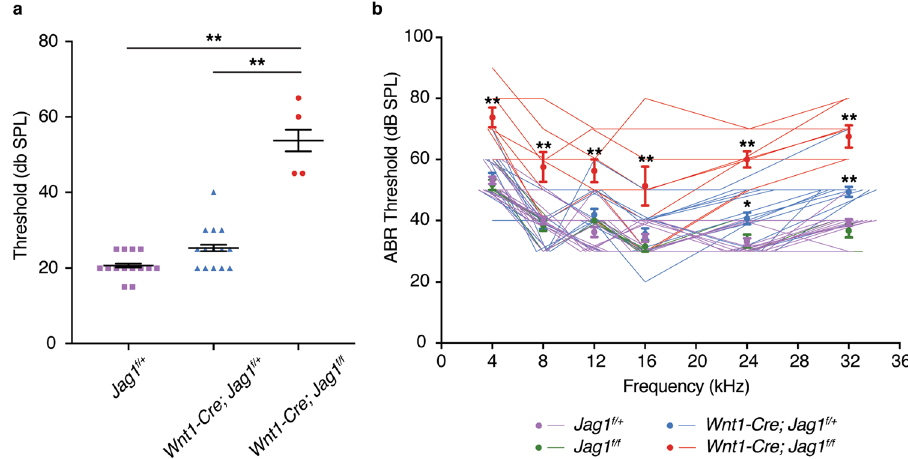
Figure 4. Hearing loss in mice lacking Jag1 in NCCs. ( a ) A click stimulus test was performed in P18 mice, a stage at which wild-type mice show normal hearing. Compared to Jag1 f/ + ( n = 7) and Wnt1-Cre ; Jag1 f/ + ( n = 7) mice, the threshold at which Wnt1-Cre ; Jag1 f/f mice ( n = 2) could hear was significantly higher. Each point represents one individually tested ear. ** p < 0.01; differences were measured by one-way ANOVA with post- hoc Tukey-Kramer HSD test. Error bars represent standard error of the mean. ( b ) Auditory brainstem responses were recorded at a range of frequencies in P18 mice. Compared to Jag1 f/ + ( n = 8), Jag1 f/f ( n = 3), and Wnt1-Cre ; Jag1 f/ + ( n = 8) mice, Wnt1-Cre ; Jag1 f/f mice ( n = 4) showed significantly higher thresholds across all frequencies as determined by a one-way ANOVA and subsequent post-hoc Tukey-Kramer HSD test. Hearing thresholds of Wnt1-Cre ; Jag1 f/ + mice were similar to Jag1 f/ + and Jag1 f/f control mice at lower frequencies but significantly different from Jag1 f/ + controls at 24 and 32 kHz. Circles represent averages, and lines represent individually tested ears. * p < 0.05, ** p < 0.01; error bars represent standard error of the